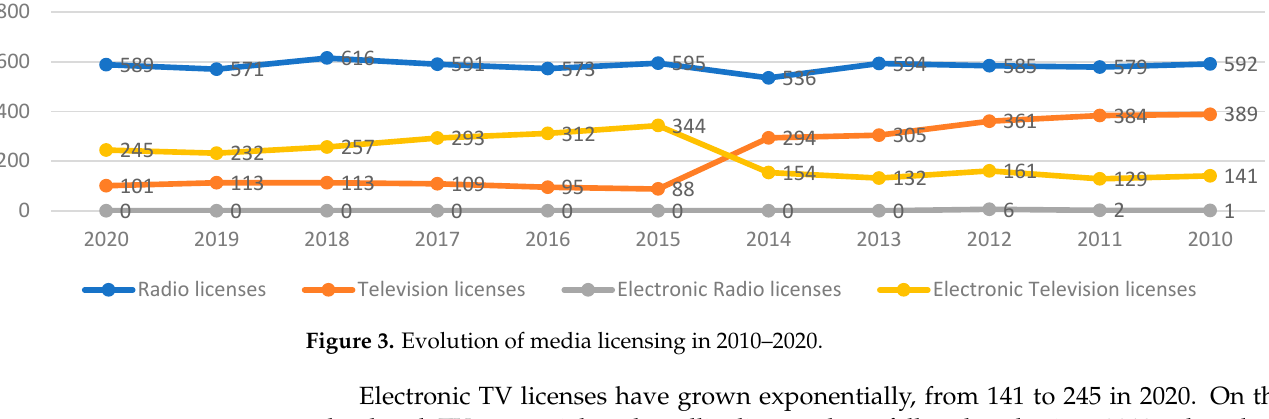
Table 3. Licenses granted for broadcasting through other electronic communications networks.